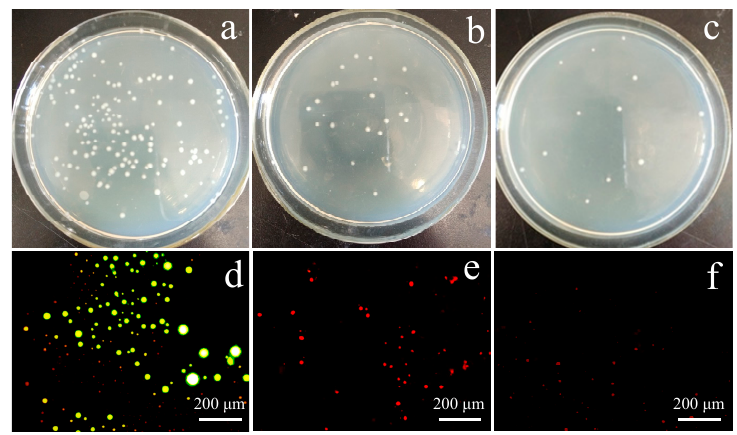
Figure 11. Pictures of Petri dishes for the neat and modified membranes: ( a ) PSf / PES; ( b ) PSf / PES-AM; ( c ) PSf / PES-AM-VT 1.0. Live (in yellow-green) / dead (in red) cell strain analysis of the membranes: ( d ) PSf / PES; ( e ) PSf / PES-AM; ( f ) PSf / PES-AM-VT 1.0.